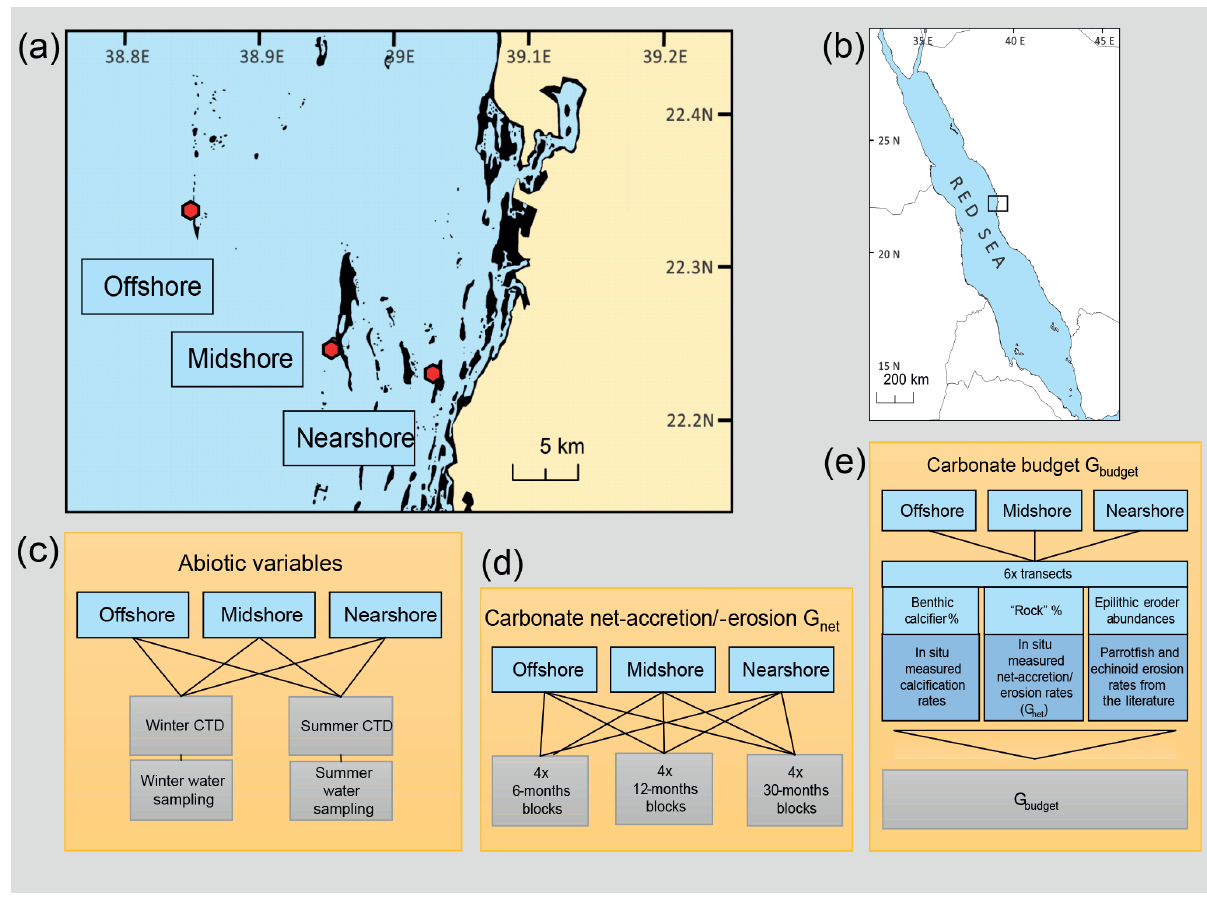
Figure 1. Design of studies and reef sites in the central Red Sea. Maps (a) and (b) indicate geographic location and the study sites along a cross-shelf gradient. Schemes in (c) – (e) summarize the study designs for the assessment of the two reef growth metrics, G net and G budget , and the characterization of the abiotic environments in the central Red Sea. Maps have been adapted from Roik et al. (2015).